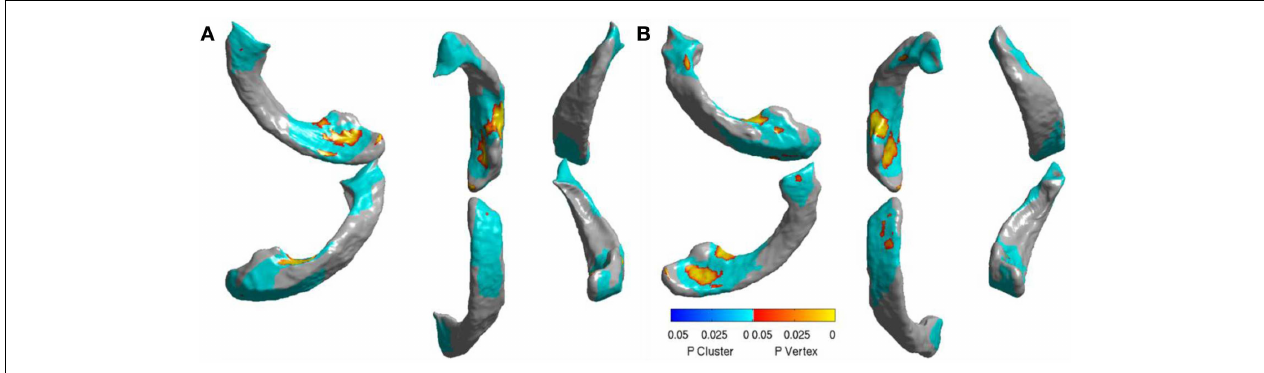
is for RV .We can clearly see that the differences are mostly localized to frontal and posterior. Please see the Section “Discussion” for further